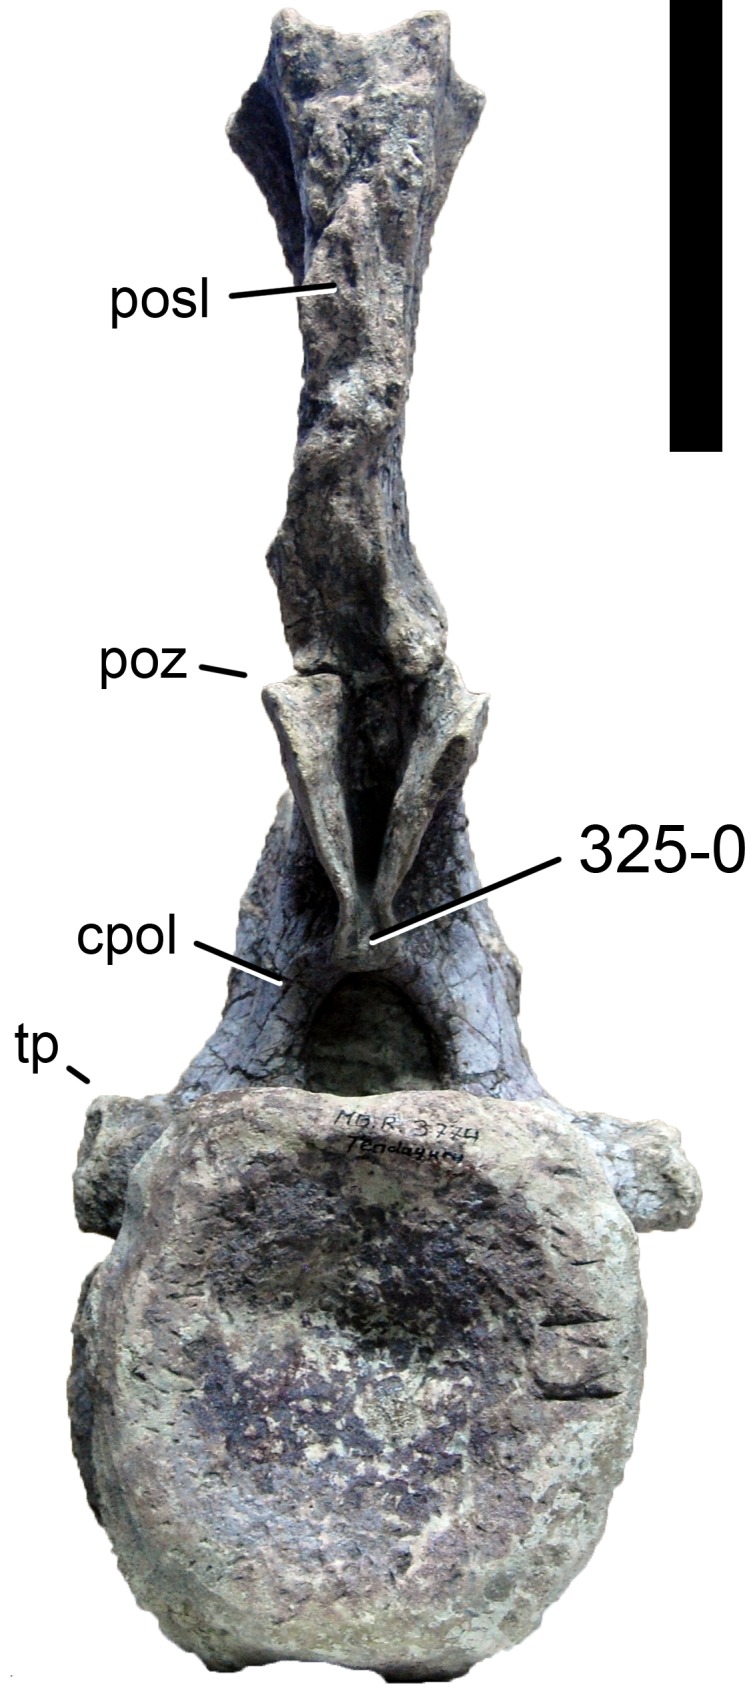
Anterior caudal vertebra of Dicraeosaurus hansemanni MB.R.3774 in posterior view.Note the hyposphenal ridge (C325-0). Abb.: cpol, centropostzygapophyseal lamina; posl, postspinal lamina; poz, postzygapophysis; tp, transverse process. Scale bar = 10 cm.